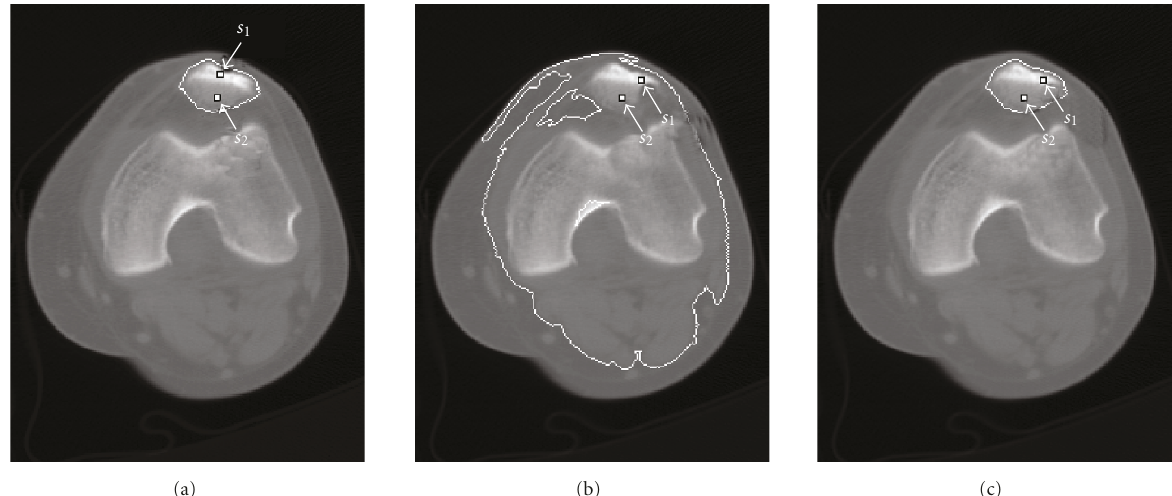
Figure 3: A CT image of a knee where the patella can be segmented with two seed pixels, s 1 and s 2 , f max with δ 3 , and without seed competition. (a) The result with a single value of κ for both seeds. (b) The segmentation with a single value of κ fails when we change the position of s 1 , because s 1 requires a higher value of κ to get the brighter part of the bone, and B invades the background at this higher value of κ . (c) The result can be corrected with distinct values of κ for each seed.